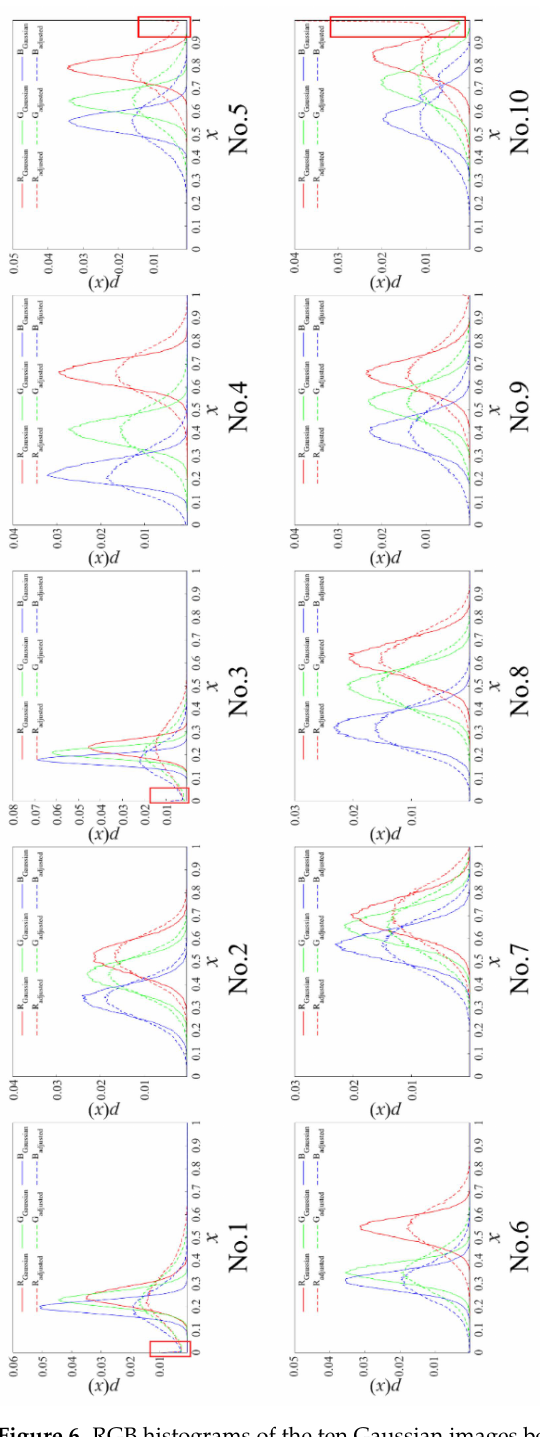
Figure 6. RGB histograms of the ten Gaussian images before and after the adaptive color